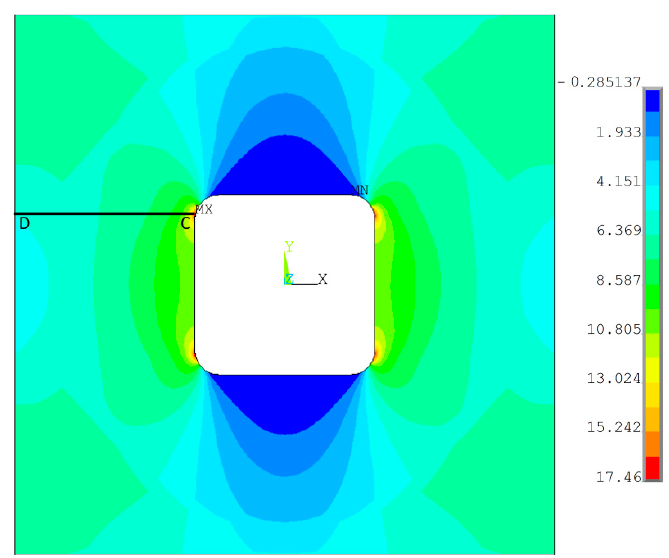
Figure 26. Path CD used for plots for distribution of tension stress σ y .